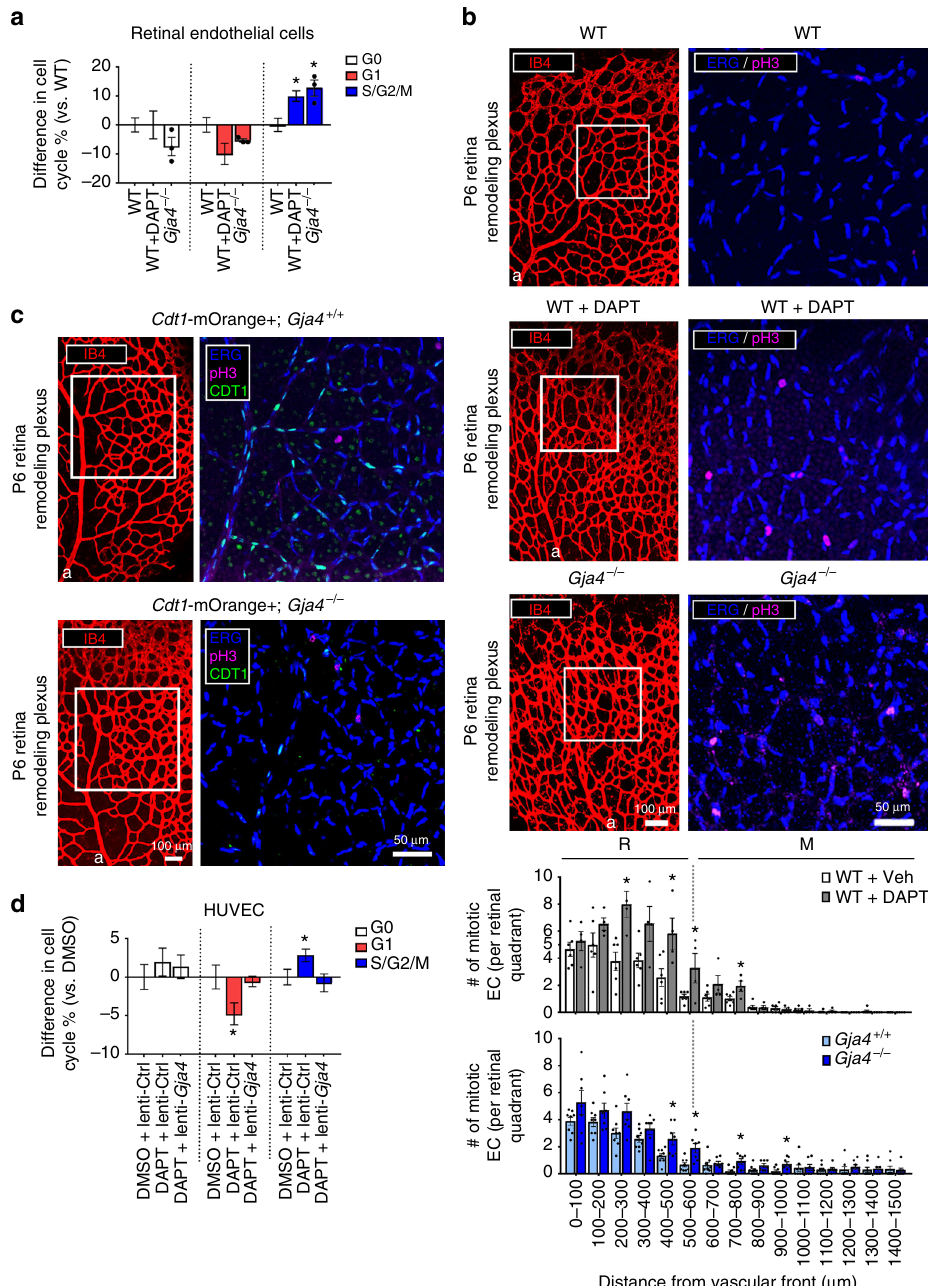
Fig. 4 NOTCH regulates endothelial cell cycle progression via GJA4. a In endothelial (CD31+/CD45 − ) cells isolated from WT+ DAPT and Gja4 − / − P6 retinas, there was a decreased proportion in G0 or G1, and increased proportion in S/G2/M, compared to WT controls (mean difference in cell cycle phase % ± SEM vs. WT ( Gja4 +/+ ); n = 6 (WT), n = 12 (WT + DAPT), n = 3 ( Gja4 − / − ); individual values plotted where n < 5; one-way ANOVA: p = 0.005 (S/G2/M), asterisks indicate p < 0.05 in post hoc t -tests). b pH3+ endothelial cells were more numerous in remodeling vessels of WT + DAPT and Gja4 − / − P6 retinas, compared to controls, and mitotic endothelial cells were mostly found at the R-M boundary (Colors: IB4 (red), ERG (blue), pH3 (magenta); scale bar: 100 µ m (low magni fi cation), 50 µ m (high magni fi cation); symbols: a = artery, r = remodeling, m = mature; mean number of pH3+/ERG + nuclei ± SEM vs control; n = 8 ( Gja4 +/+ , Gja4 − / − ), n = 6 (WT), n = 4 (WT + DAPT); Students ’ t -test: p = 0.006 (WT + Veh vs. WT + DAPT, 200 – 300 µ m), p = 0.03 (WT + Veh vs. WT + DAPT, 400 – 500 µ m), p = 0.04 (WT + Veh vs. WT + DAPT. 500 – 600 µ m), p = 0.04 (WT + Veh vs. WT + DAPT, 700 – 800 µ m), p = 0.04 ( Gja4 +/+ vs. Gja4 − / − , 200 – 300 µ m, p = 0.02 ( Gja4 +/+ vs. Gja4 − / − , 400 – 500 µ m), p = 0.005 ( Gja4 +/+ vs. Gja4 − / − , 500 – 600 µ m), p = 0.005 ( Gja4 +/+ vs. Gja4 − / − , 700 – 800 µ m), p = 0.03 ( Gja4 +/+ vs. Gja4 − / − , 900 – 1000 µ m)). c The nuclei of endothelial cells in G1 were marked by CDT1-mOrange in remodeling vessels of Cdt1 -mOrange+; Gja4 +/+ reporter mice. CDT1-mOrange signal in endothelial cells of remodeling vessels in Gja4 − / − reporter mice was greatly reduced, compared to WT controls. (Colors: IB4 (red), ERG (blue), pH3 (magenta), CDT1 (green); scale bar: 100 µ m (low magni fi cation), 50 µ m (high magni fi cation); symbols: a = artery). d In HUVEC, DAPT decreased the proportion of cells in G1 and increased the proportion in S/G2/M; constitutive GJA4 expression (via lenti- Gja4 ) abolished these cell cycle effects of DAPT (mean difference in cell cycle % ± SEM vs. DMSO; n = 9 (DMSO), n = 7 (DAPT), n = 8 (DAPT+lenti- Gja4 ); one-way ANOVA: p = 0.04 (G1), p = 0.03 (S/G2/M), asterisks indicate p < 0.05 in post hoc t